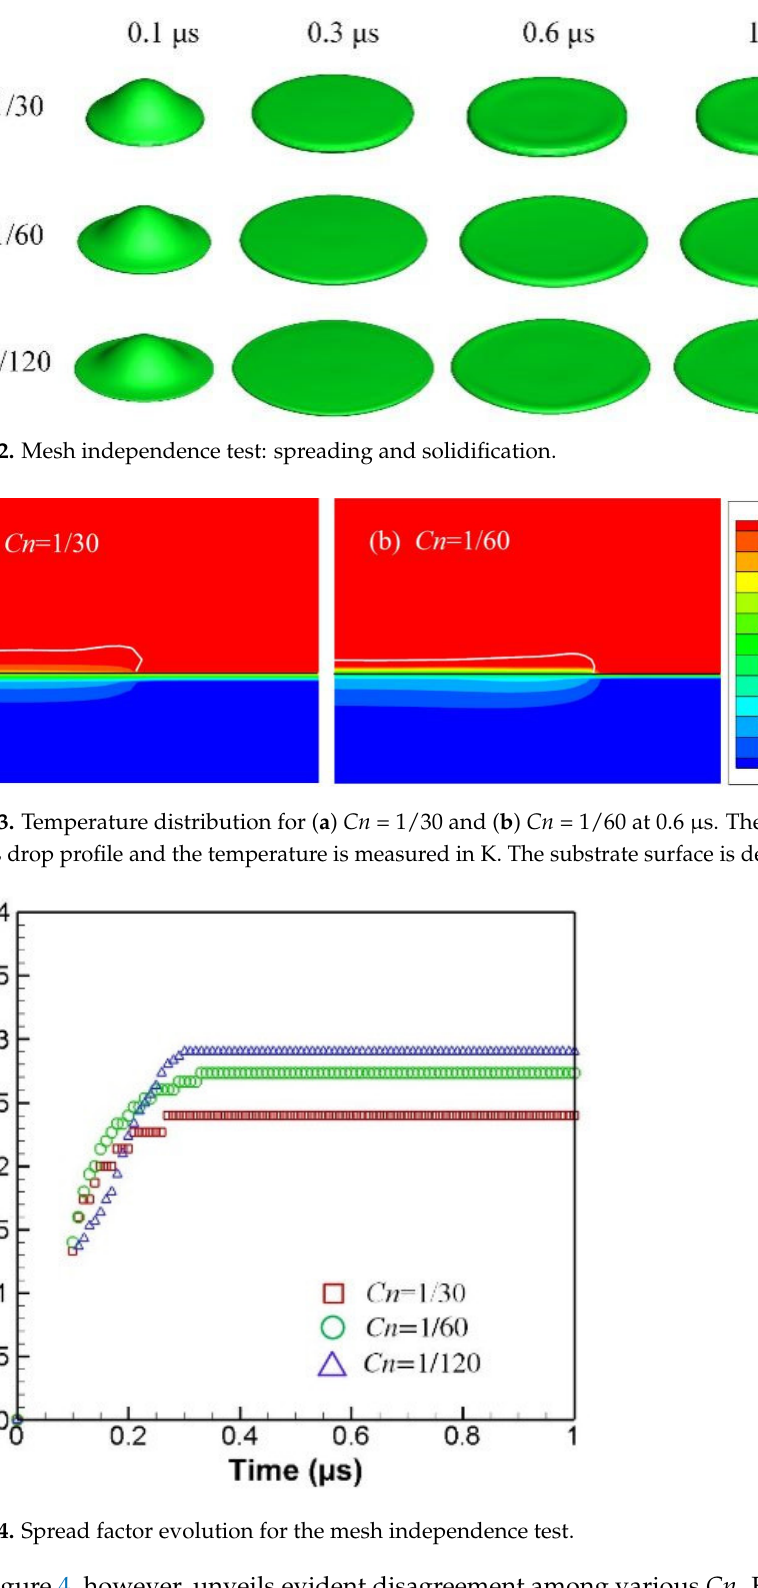
Figure 4. Spread factor evolution for the mesh independence test.